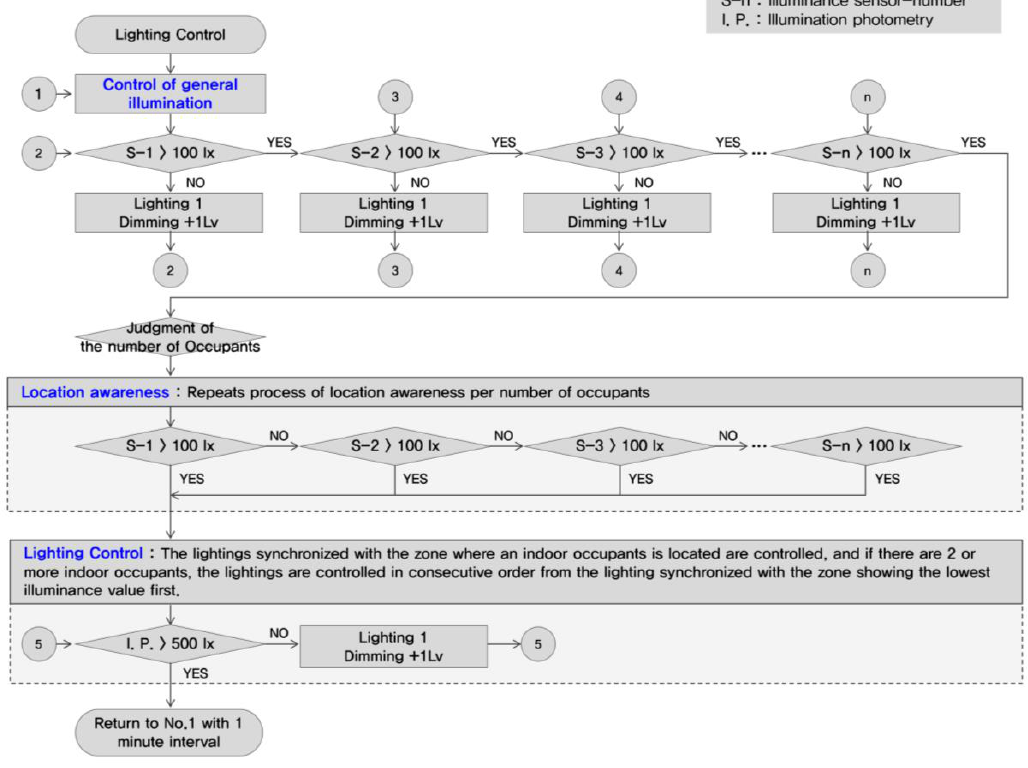
Figure 2. The algorithm for the dimming lighting control using the general lighting and occupant location-awareness technology. location-awareness